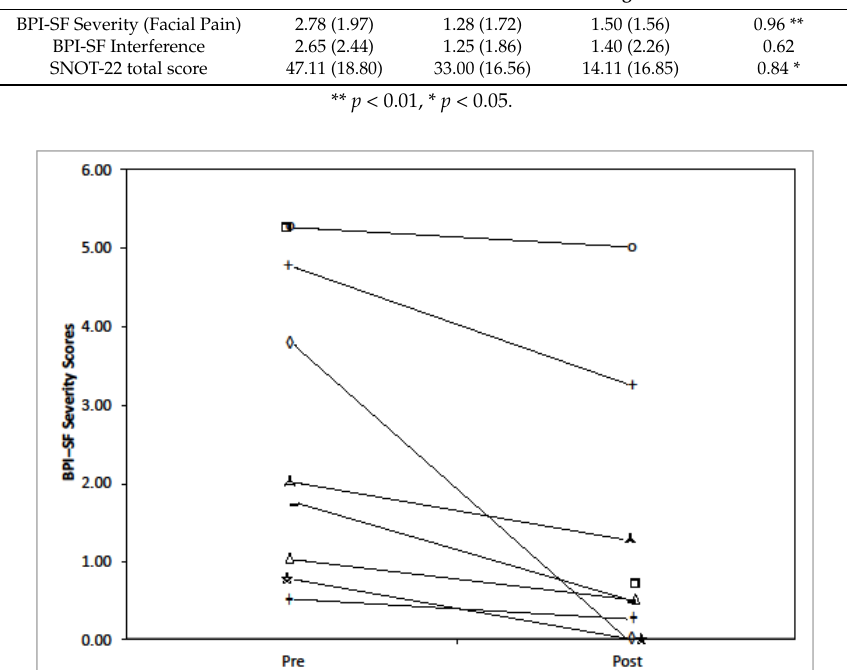
Figure 3. Improvement in BPI-SF severity domain pain scores for patients with baseline facial pain after six treatments. Table 2. Treatment results for all patients ( n = 14). Five patients reported no baseline facial pain. Mean scores, SD, effect sizes (Cohen’s d ) and p -values were calculated.